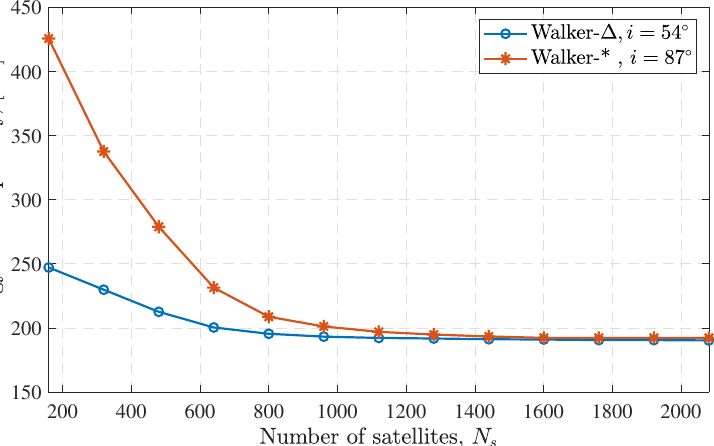
Figure 15. The energy wasted per day for case I as a function of the number of satellites in the constellation. The IoT devices transmit power is P t = 27